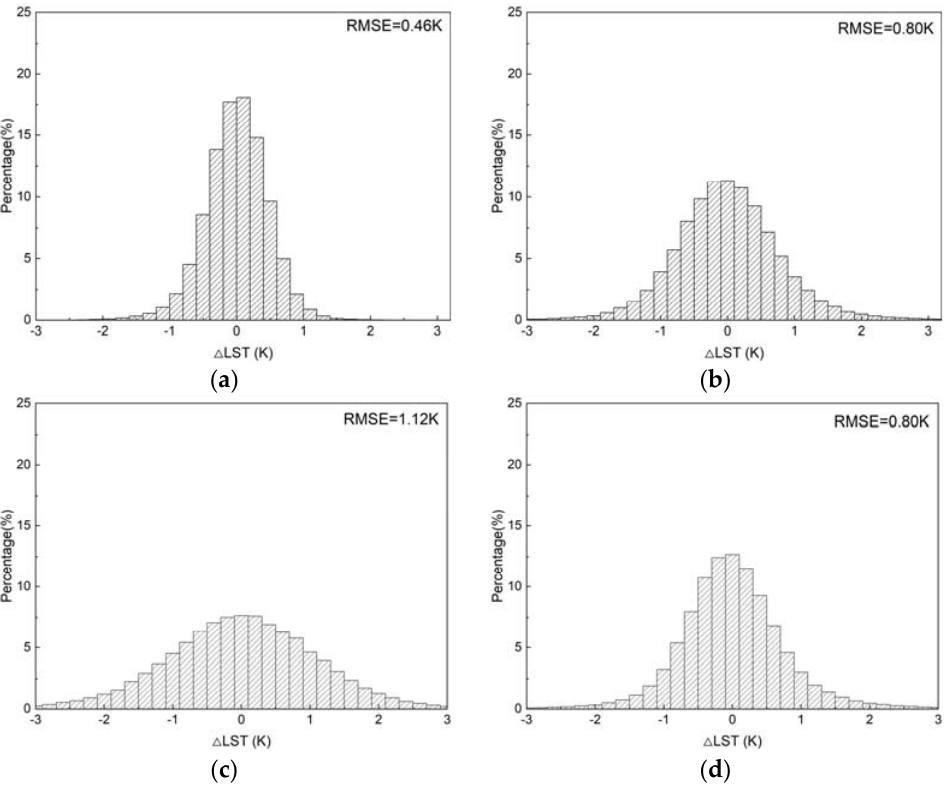
Figure 3. LST residuals histograms of the TIR SW algorithm. ( a ) Polar; ( b ) mid-latitude. ( c ) tropical; ( d ) overall.